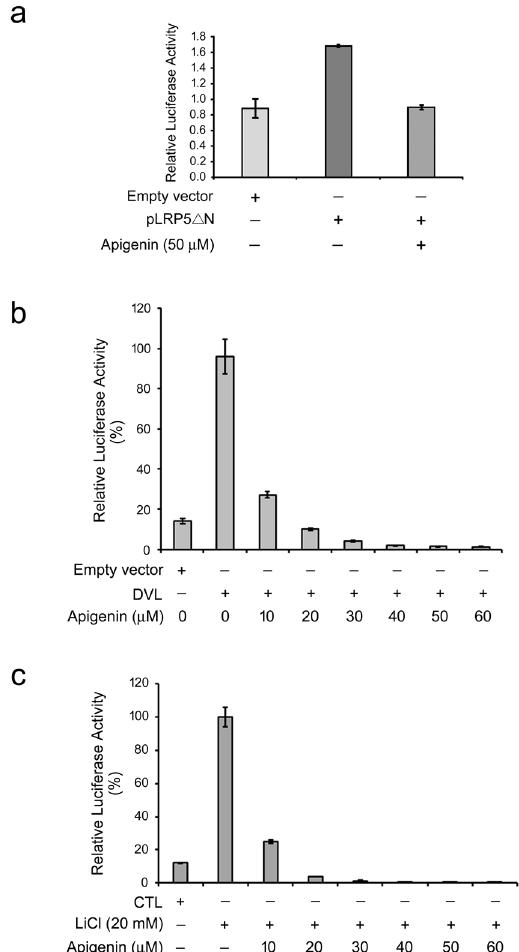
Figure 4. Apigenin acts on GSK3 β per se or downstream of GSK3 β in the Wnt signaling pathway. ( a ) Apigenin acts on LRP5 or downstream of LRP5 in the Wnt/ β -catenin signaling pathway. P19 cells were transfected with two reporter plasmids together with pLRP5 Δ N (grey bar and heavy grey bar), or empty vector (light grey bar), then treated with 50 μ M of apigenin, and assayed for dual luciferase activities. The luciferase activity from the expression of empty vector alone was set as 1.0, and the relative activity of other treatment was calculated accordingly. ( b ) Apigenin acts on DVL or downstream of DVL in the Wnt signal transduction pathway. P19 cells were transfected with two reporter plasmids together with DVL2 plasmid, or empty vector, then treated with different concentrations (0~60 μ M) of apigenin, and assayed for dual luciferase activities. The luciferase activity from the expression of DVL alone was set as 100%, and the relative activity of other treatment was calculated accordingly. ( c ) Apigenin acts on GSK3 β or downstream of GSK3 β in the Wnt signaling pathway. P19 cells were transfected with two reporter plasmids, incubated in culture medium (CTL) or treated with 20 mM of LiCl as well as different concentrations (0~60 μ M) of apigenin in culture medium, and then assayed for dual luciferase activities. The luciferase activity of LiCl treatment alone was set as 100%, and the relative activity of other treatment was calculated